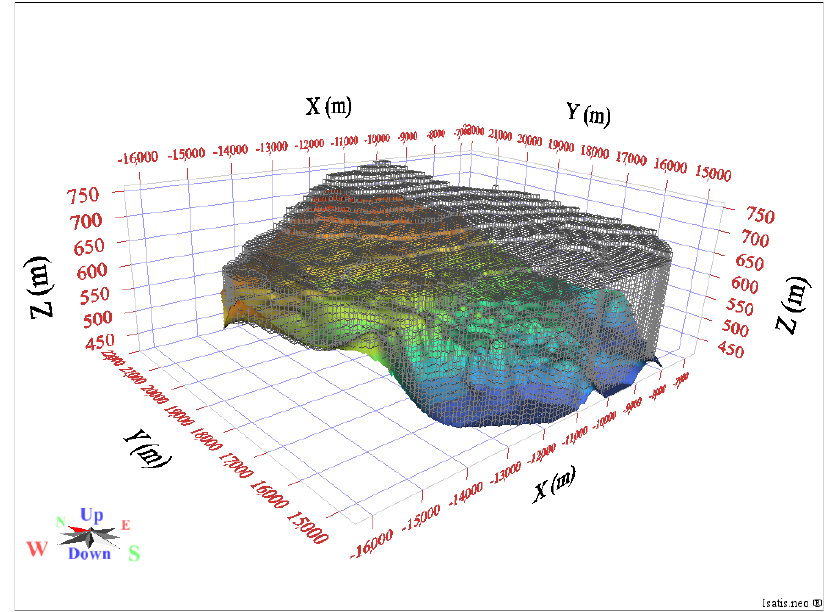
Figure 6. Discretization of the study domain.